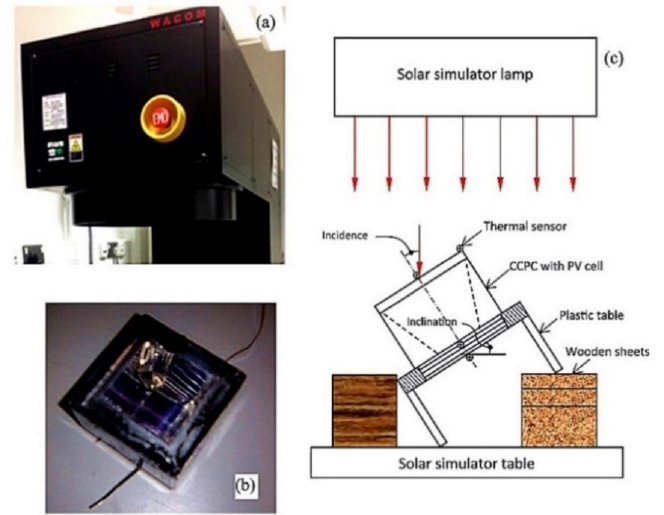
Figure 10. WXS-210S-20 solar simulator ( a ), a picture of the Crossed Compound Parabolic Concentrators (CCPC) with PV cell ( b ) and a position of the CCPC in experiment ( c ) [76].